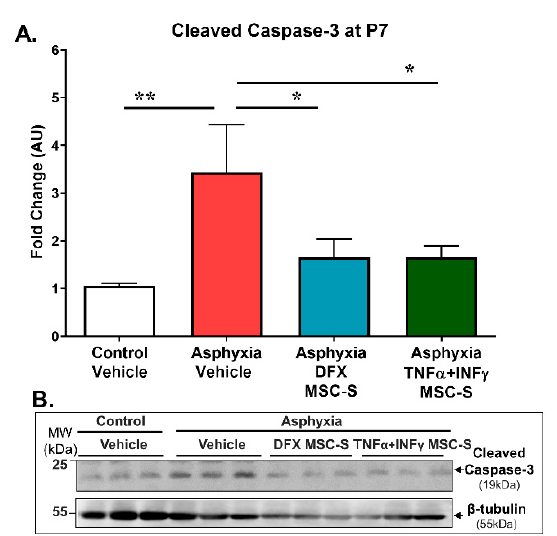
Figure 6. E ff ect of intranasal administration of DFX- or TNF- α + IFN- γ -MSC-S on hippocampal cell death (cleaved-caspase-3) induced by PA at P7. Cleaved-caspase-3 protein level evaluated by Western blot at P7 in control (CS, white bar) and asphyxia-exposed rats (AS, red bar), intranasally treated with vehicle- or DFX-MSC-S (cyan bar), or TNF- α + IFN- γ -MSC-S (green bar). β -tubulin was used as normalizer. Data are presented as ratios of protein levels / normalizer levels, relative to vehicle control levels. Data represent means ± SEM. ( A ) Cleaved-caspase-3 protein levels: AS rats showed an increased level of cleaved-caspase-3 protein, versus CS rats. Administration of a single dose of DFX- or TNF- α + IFN- γ -MSC-S reversed the e ff ect of PA on cleaved-caspase-3 levels. One-way ANOVA, F (3,22) = 3.985, * p < 0.05. Benjamini, Hochberg, and Yekutieli post-hoc: ** p < 0.005; CS v / s AS; * p < 0.05; AS v / s Asphyxia-DFX-MSC-S; * p < 0.05; AS v / s Asphyxia-TNF- α + IFN- γ -MSC-S, N = 7–6 samples per group. ( B ) Representative Western blot image is shown.